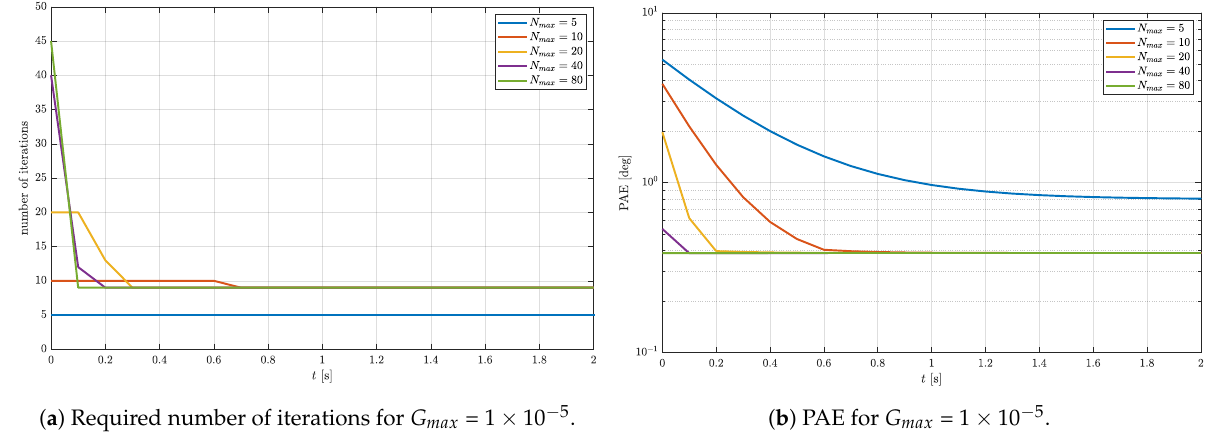
Figure 3. Required number of iterations and PAE of the estimated rotational quaternion ( µ = 0.7). The same simulation is repeated with N max set to the fixed value of 100, while G max is varied in the range from 1 × 10 − 9 to 1 × 10 − 5 . Since the number of iterations is set to a relatively high value, a quick convergence is expected for each G max . This is confirmed by the results shown in Figure 4a. However, the number of iterations in a steady state is not equal for every G max . The lower the G max , the higher the number of iterations required for reaching the desired accuracy. This is evident from Figure 4b as well. If G max is smaller, the small PAE is reached in a steady state. This is a clear confirmation that parameters G defined in (22) and G max represent a valid figure of merit and termination criterion.